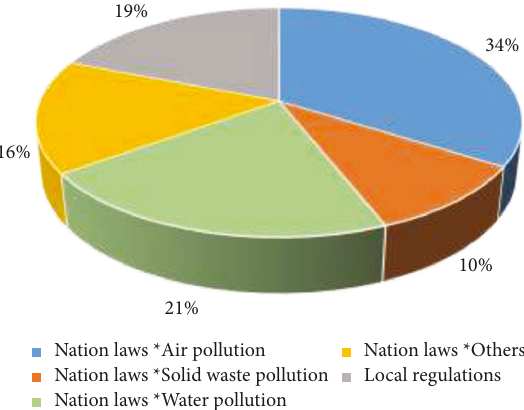
Figure 2: Localization degree of punishment